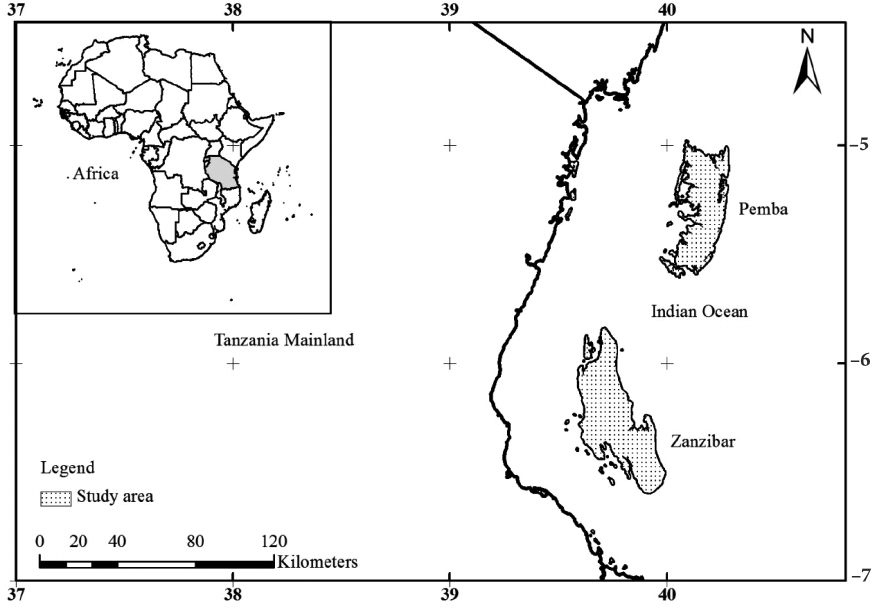
Figure 1. Map showing the study